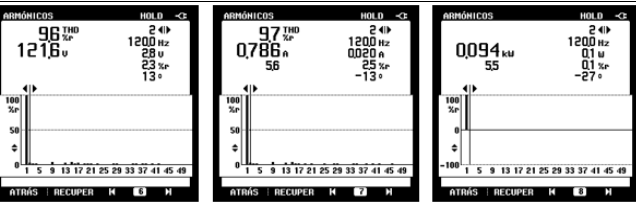
Figure 14: Harmonic components obtained by Fluke 43B analyzer in multilevel inverter with resistive